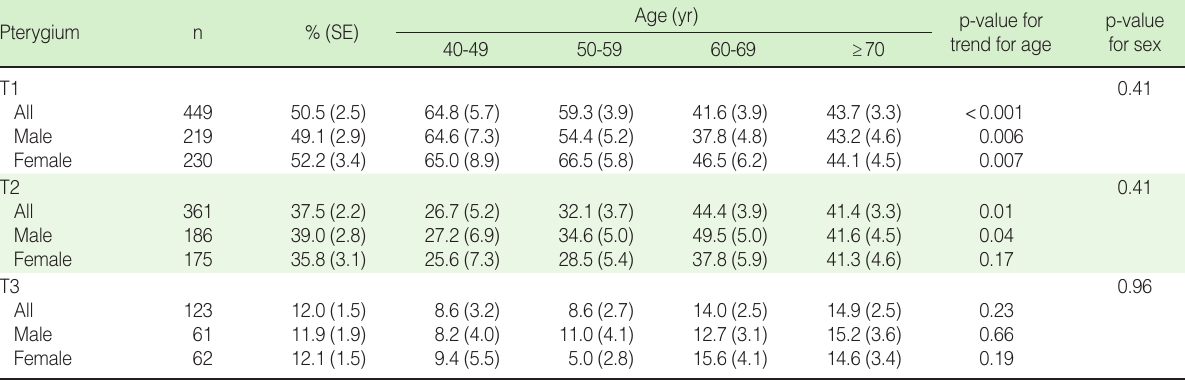
Age (yr) p-value for trend for